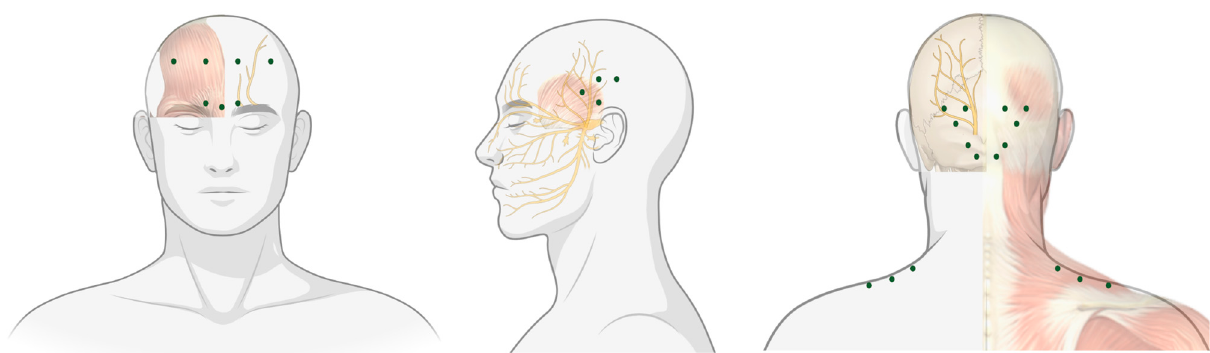
Figure 1. The PREEMPT protocol for injection of onabotulinumtoxinA (stylised)—green dots represent injection sites [12].